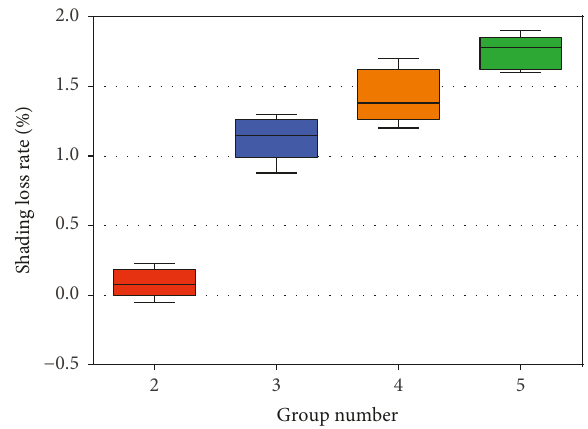
Figure 4: The shading rate of the conductive belts for groups 2 to